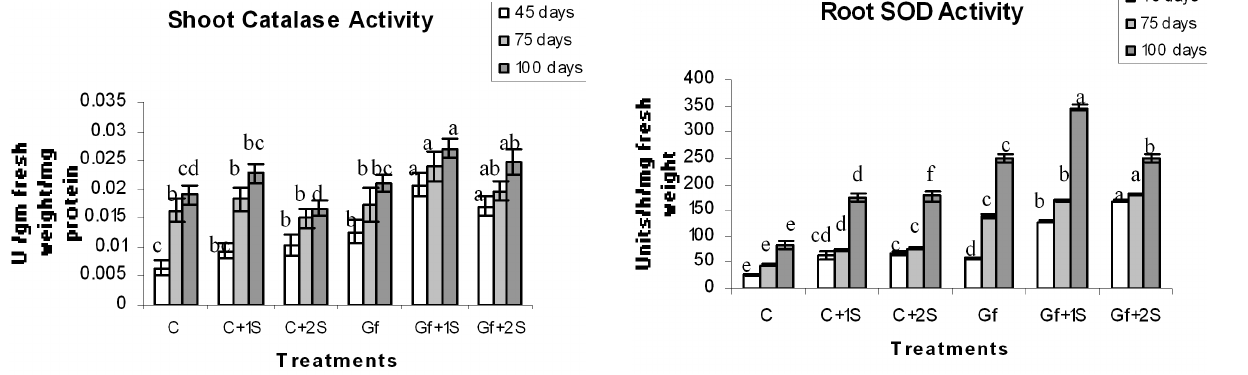
Fig. 11. Root superoxide dismutase activity in Gmelina arborea Roxb inoculated with Glomus fasciculatum after 45, 75 and 100 days after AM